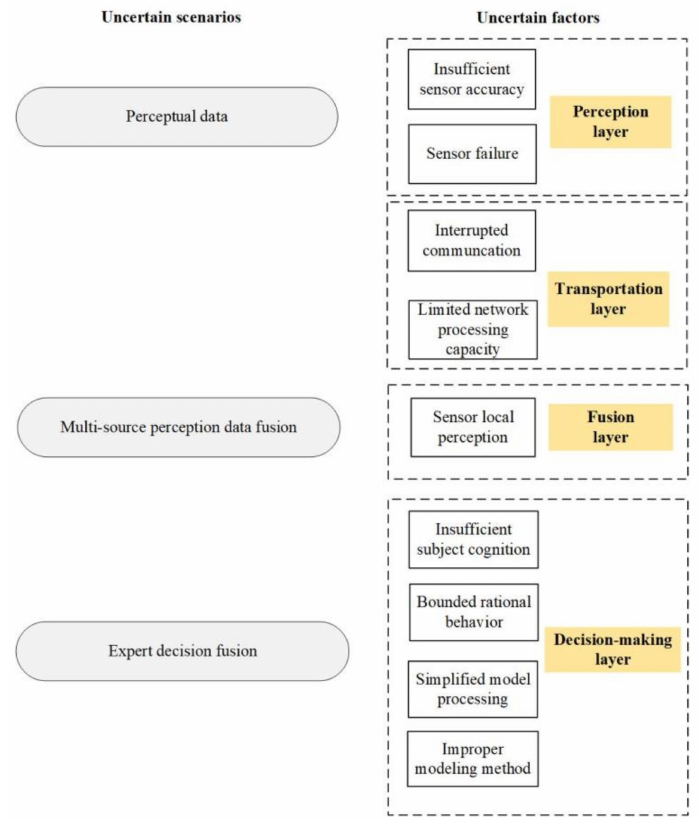
Figure 6. Identification of uncertainty factors and